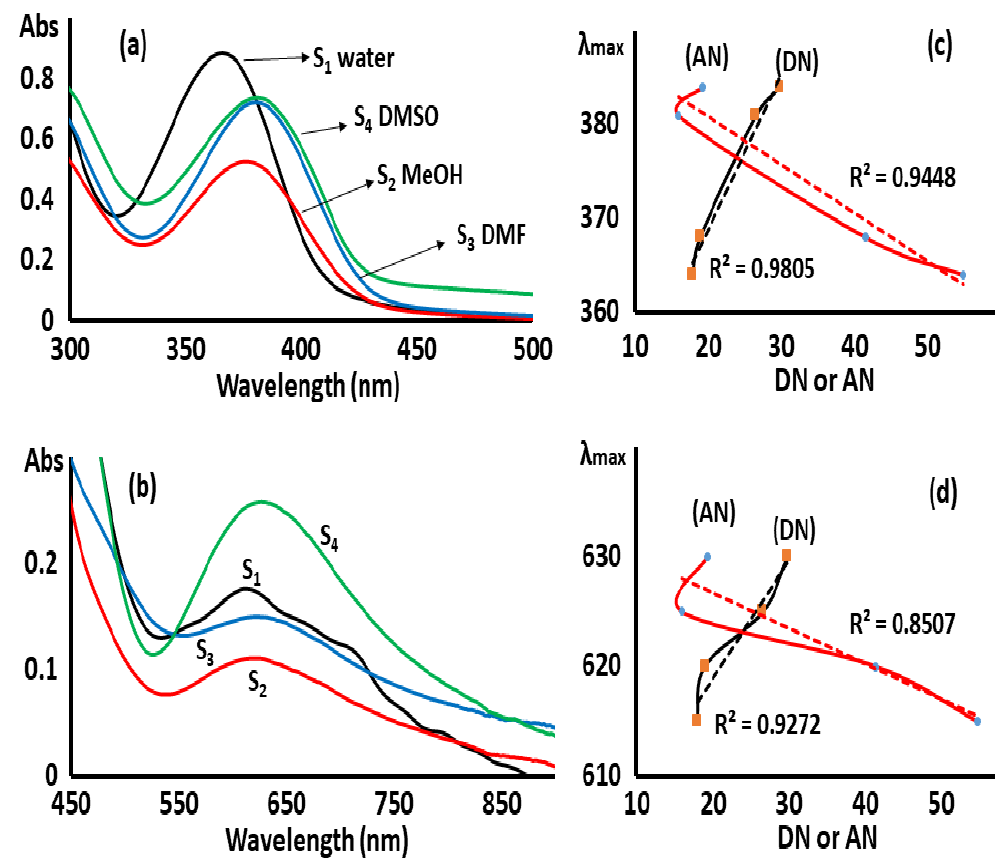
Figure 8. Solvatochromism of complex 2 : Abs. vs. λ max at LMCT ( a ) and at d-d ( b ), λ max vs. solvents DN/NA at LMCT ( c ) and at d-d ( d ).